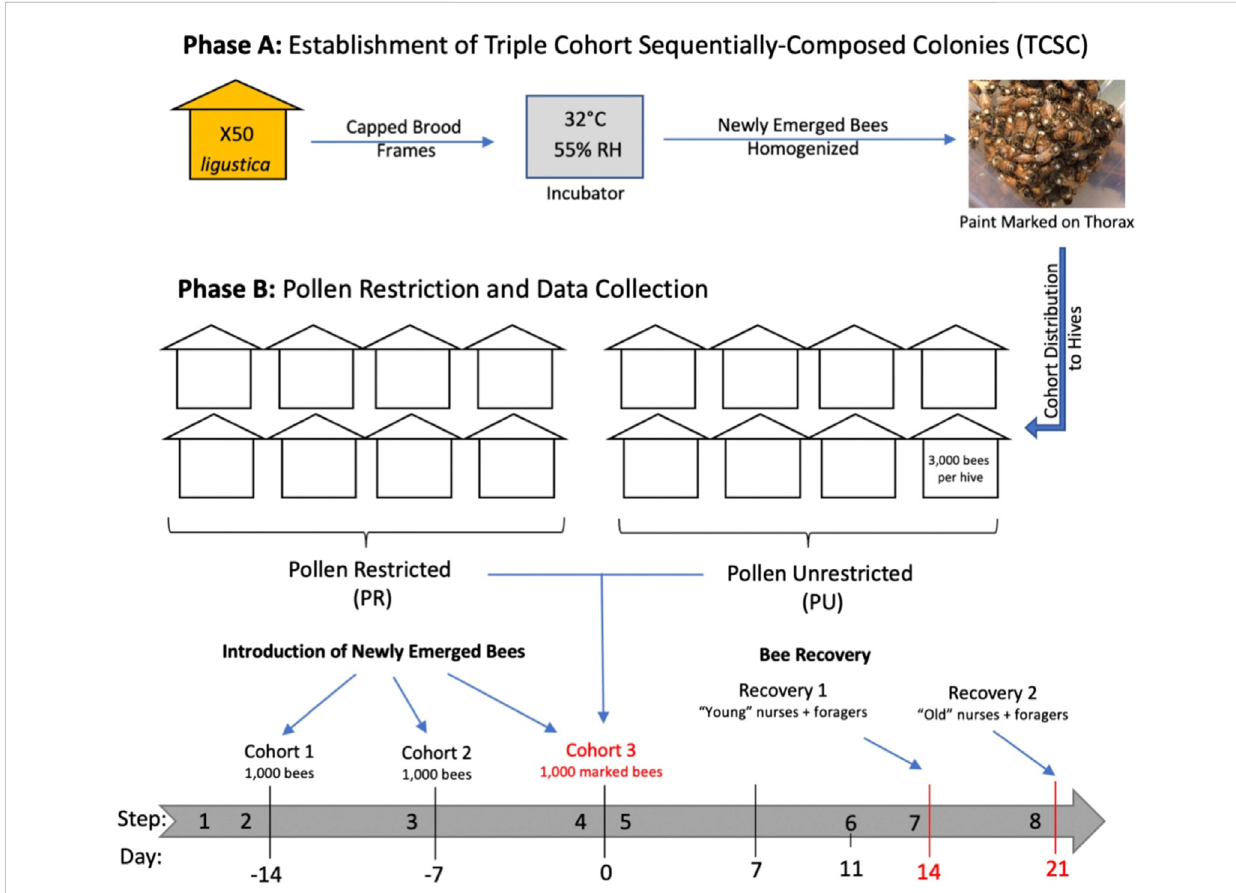
FIGURE 1 Timelineofexperimentaldesign.Numbersbelowthegreyarrowrefertodaysbeforeandaftertheendofthecolonyestablishment.Establishmentof sixteen triple cohort sequentially-composed colonies (TCSC) using newly emerged bees from 50 Italian colonies. Each TCSC colony consisted of one framewithpollen,onewithhoney,oneemptycomb,andonebuiltframecontainedinaqueen-isolatorcage(step1).Onethousandnewlyemergedbees wereintroducedintoeachhive(cohort1).Sixteensisterqueenbeeswereintroducedwithcohort1andkeptcon fi nedinqueen-insulatorcages(step 2). Two subsequent batches of one thousand newly emerging bees were introduced after 1 week (cohort 2) (step 3) and after 2 weeks (cohort 3) (step 4). Two experimental nutritional groups were formed: pollen-restricted (R) and unrestricted (U) colonies (N = 8 per group) (step 5). Pollen restriction was carriedoutbyremovingframescontainingpollenandactivatingthepollentraps.Foragingstartedwhenbeeswere11daysold(step6).Molecularanalyses were conducted on two sets of recovered two-week-old ( “ young ” ) (step 7) and three-week-old ( “ old ” ) (step 8) nurses and